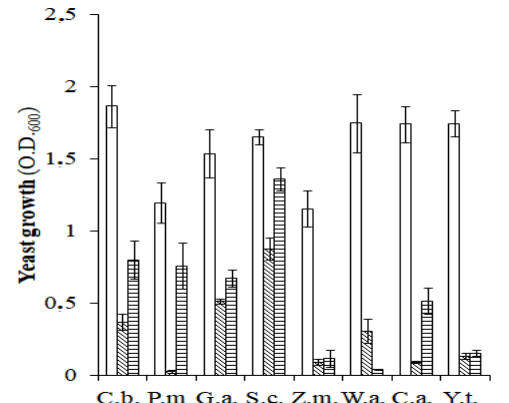
Figure 3. Oleuropeinolytic yeast growth in the absence of NaCl in aerobiosis ( ), anaerobiosis ( ), and slightly pressurized CO 2 ( ) conditions. C.b., Candida boidinii ; P.m., Pichia manshurica ;